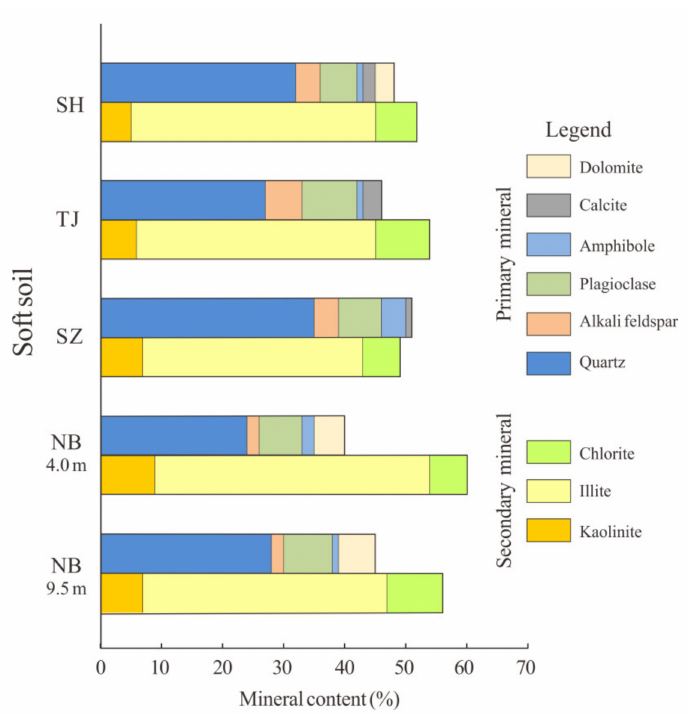
Figure 3. Mineral content of soft